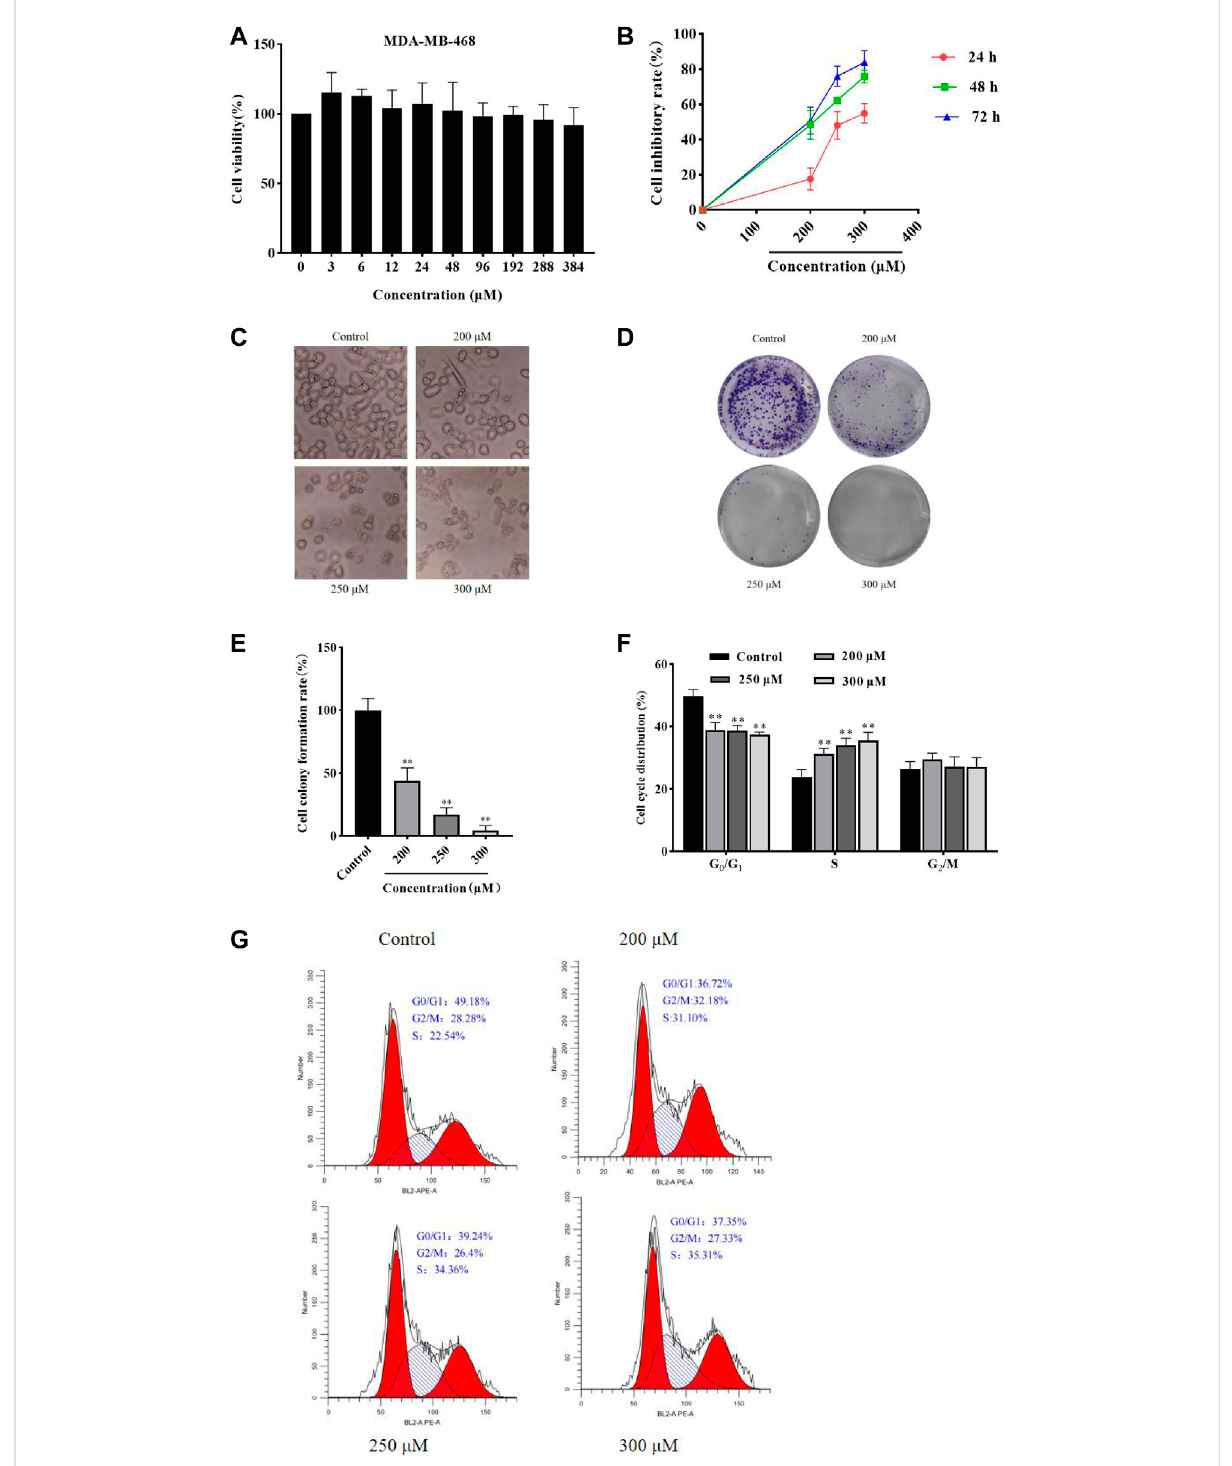
FIGURE 1 GA inhibited HCC1806 cells viability and affected cells morphology, and affected HCC1806 cells proliferation and cycle distribution. (A) The MDA-MB-468 cells viability was detected by MTT assay. (B) The HCC1806 cell inhibitory rate was detected by MTT assay. (C) The morphology changesofHCC1806cellstreatedwithdifferentconcentrationsofGAwereobservedunderaninvertedmicroscope. (D,E) EffectofGAonthecolony formation rate of HCC1806 cells. (F,G) The cell cycle distribution of HCC1806 were assessed by fl ow cytometry. Date were expressed as means ± SD. Compared with the control group, ** p <